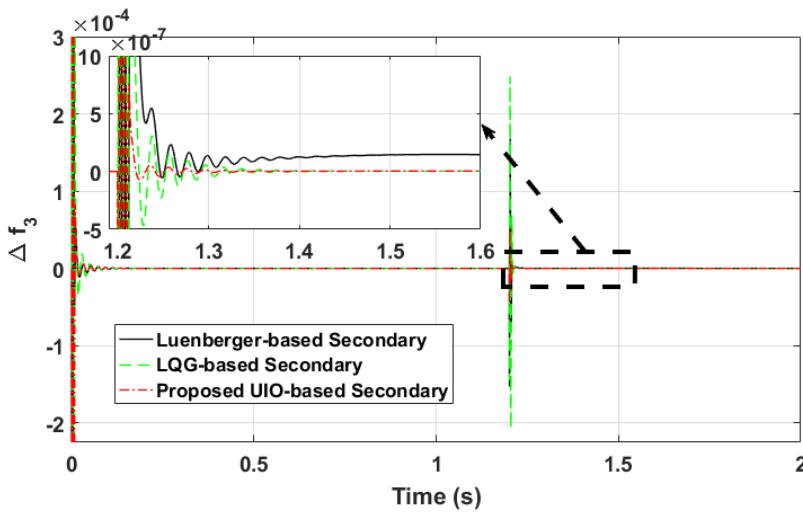
Figure 13. Third inverter frequency dynamic ∆ f 3 in scenario 2 (FDI into second inverter’s actuator).